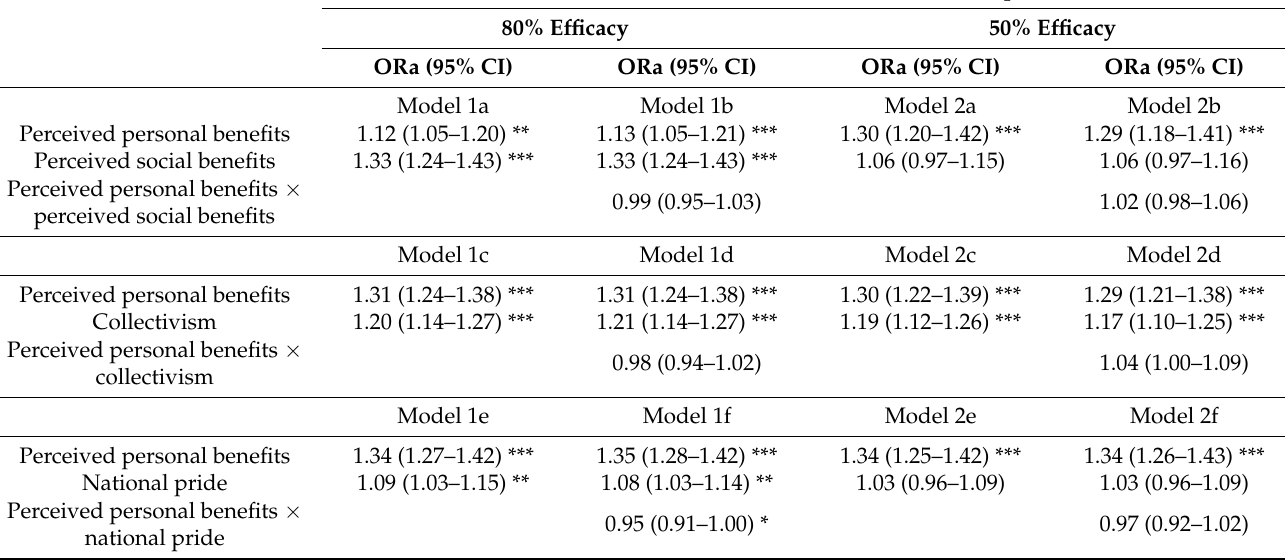
Table 4. Interaction effects (standardized